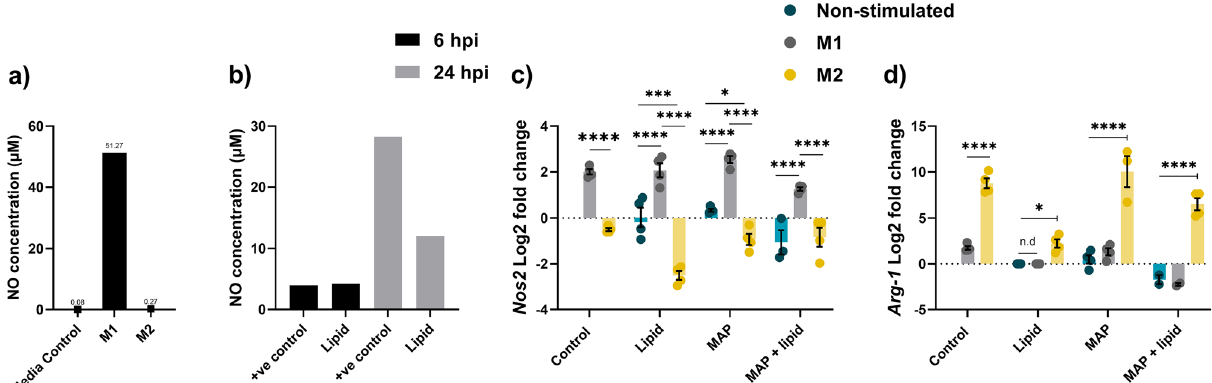
Figure 1. MAP infection maintains an M1 macrophage state during early infection. RAW264.7 macrophages were polarised to an M1 or M2 state and further supplemented with exogenous lipid and/or infected with MAP. Cellular NO production was measured using a Griess assay at ( a ) 22 h post polarisation (n = 3) and ( b ) 6 and 24 h post lipid supplementation (n = 2); LPS stimulation was used as a positive control. Expression of Nos2 (M1 marker) ( c ) and Arg-1 (M2 marker) ( d ) was assessed by qPCR at 24 hpi. Arg-1 was not detected (n.d) in unstimulated and M1 macrophages supplemented with lipid (n = 2). Controls are the polarised cells without lipid or MAP. Error bars show standard deviation. *p ≤ 0.05, **p ≤ 0.01, ***p ≤ 0.001, ****p ≤